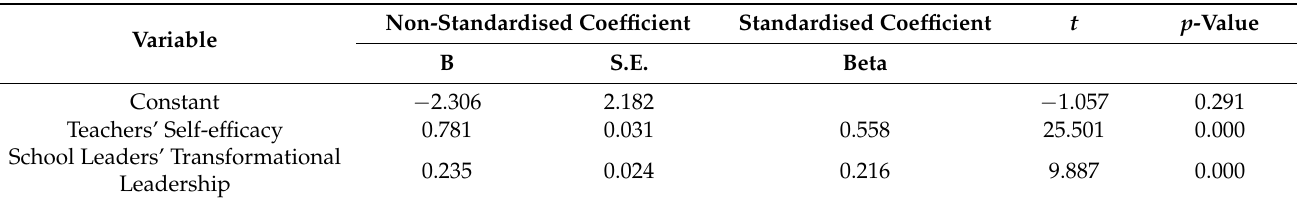
Table 17. Multiple regression coefficient